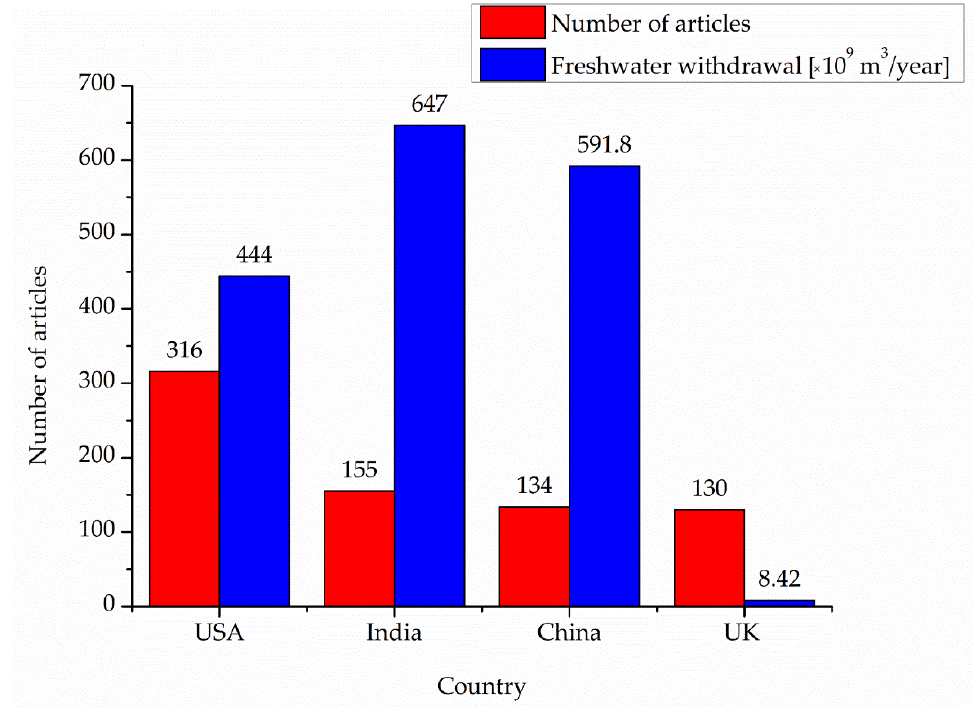
Figure 13. Correlation between scientific productivity and freshwater withdrawal for the top four countries.